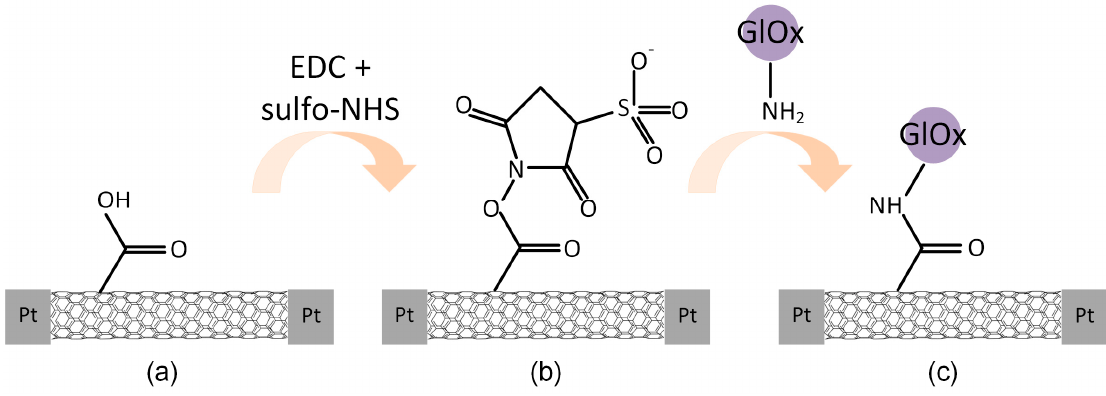
Figure 4. Illustration of the functionalization steps with the corresponding enzymes: ( a ) CNTs featuring carboxylic groups at the surface; ( b ) intermediate stage after the EDC and sulfo-NHS coupling; ( c ) final state after coupling with glutamate oxidase.